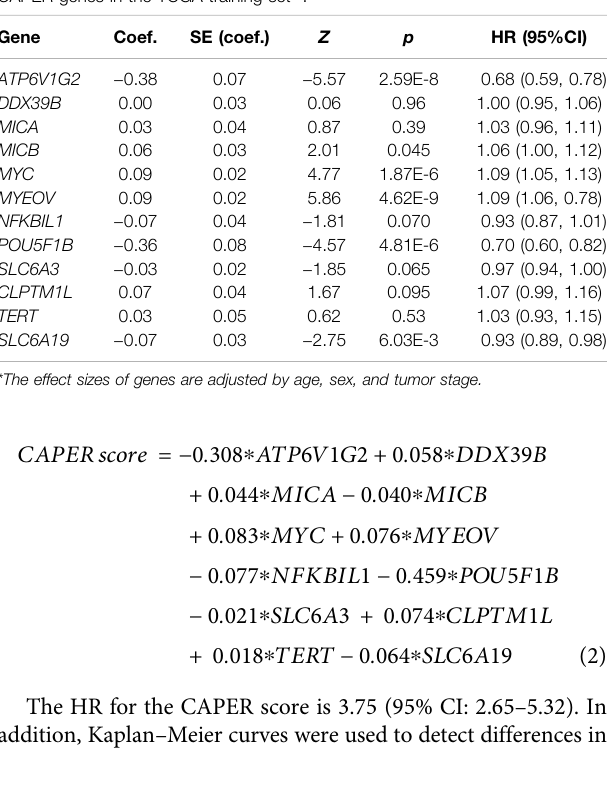
found to be signi fi cant (log-rank test, p < 0.0001), with the ( Figure 3C ).